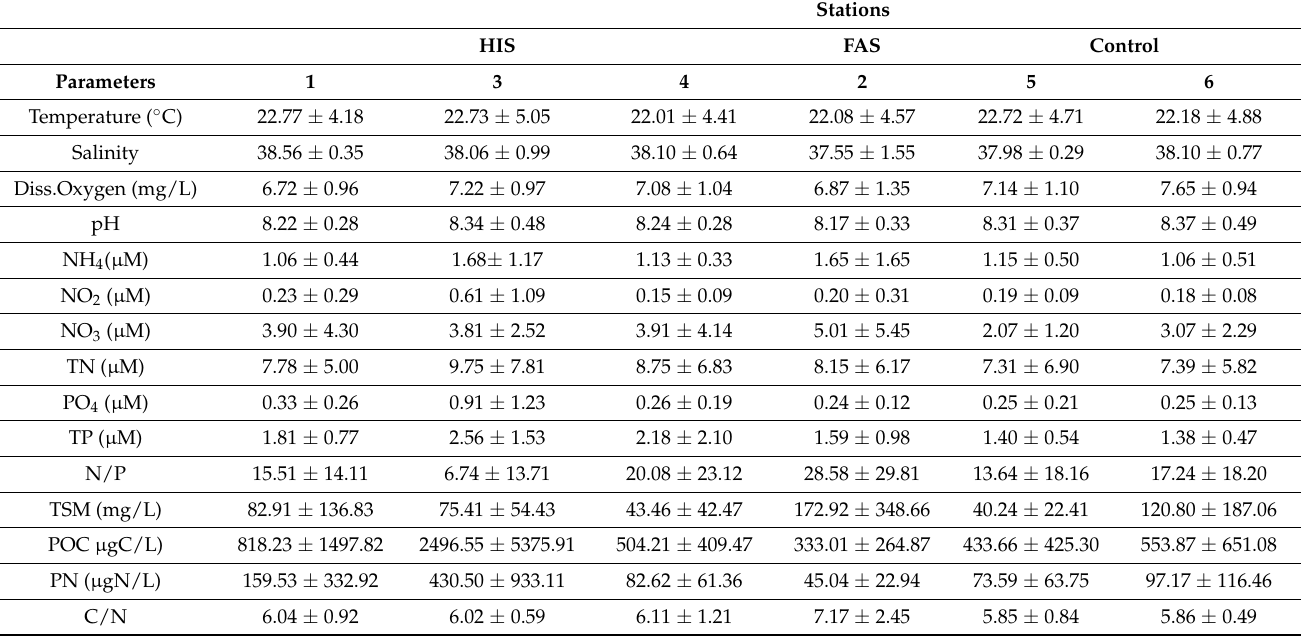
Table 3. Mean values ± standard deviation of the environmental parameters measured in the Syracuse bay, separately per human-impacted stations (HIS), Stations 1, 3 and 4; freshwater-affected (FAS), Station 2; control stations (control), Stations 5–6.